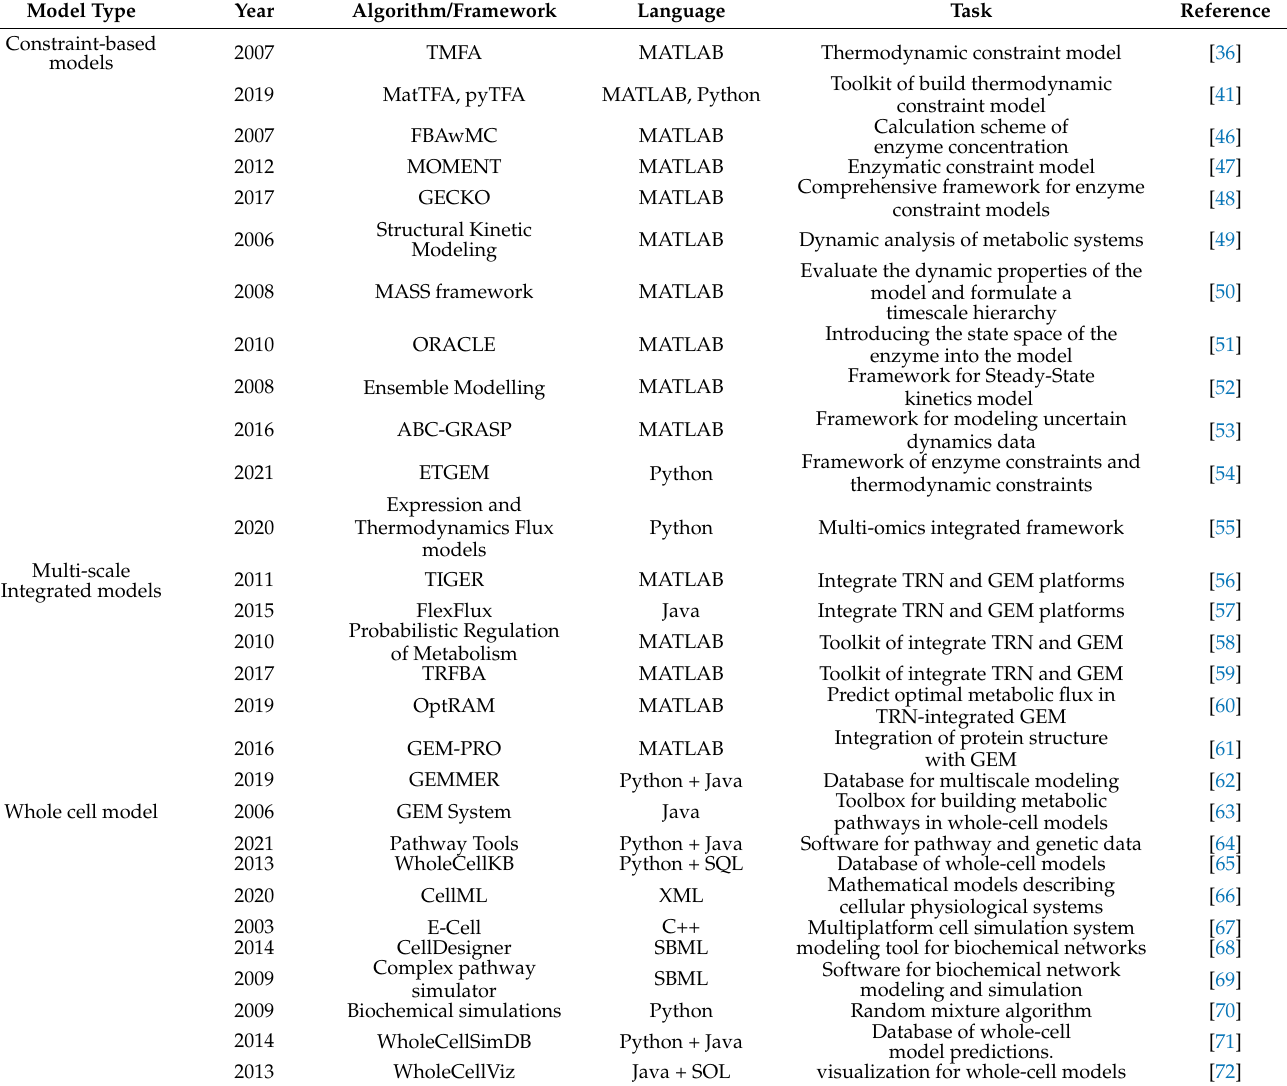
Table 1. Algorithms and frameworks for the construction and application of multiscale models. Model Type